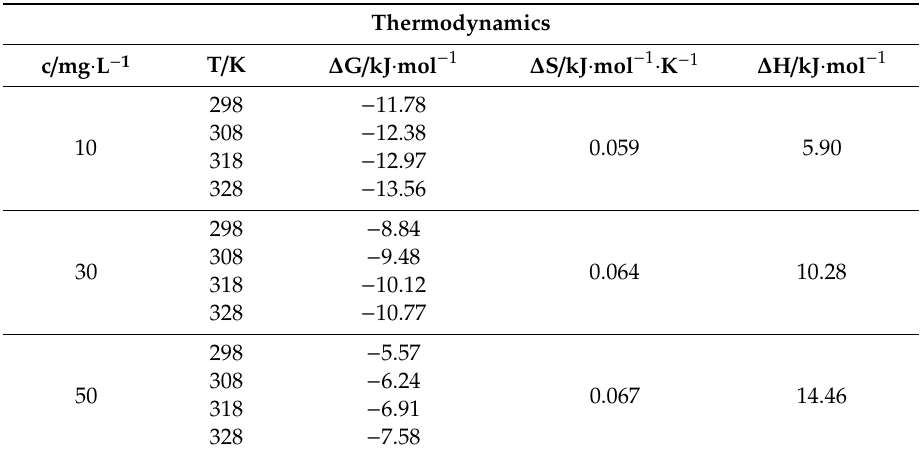
Table 5. Thermodynamic parameters for removal e ffi ciency of MB on SLS-C.